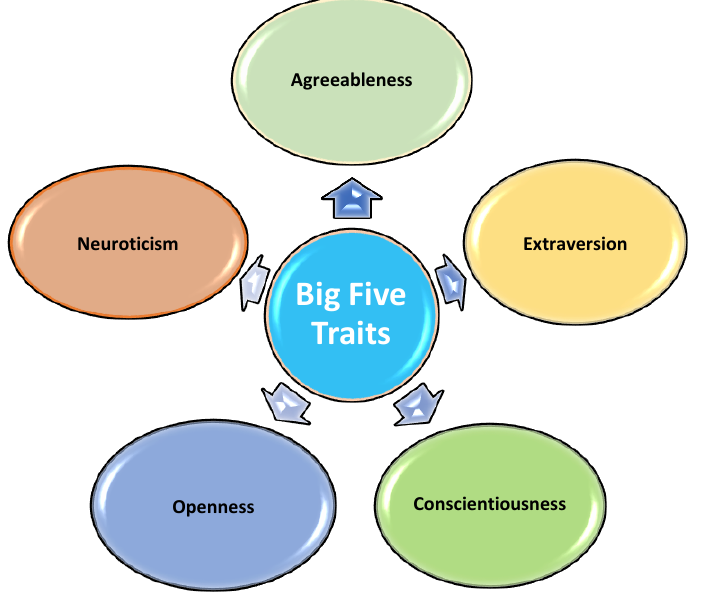
Figure 1. Big Five personality traits.